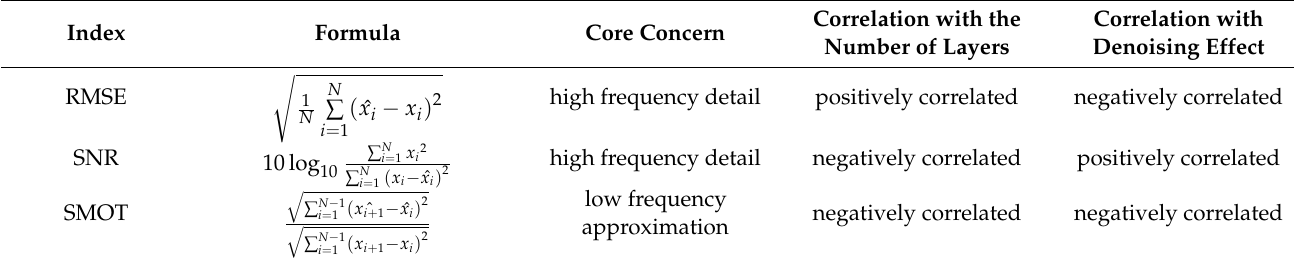
Table 1. Formulas and characteristics of three evaluation